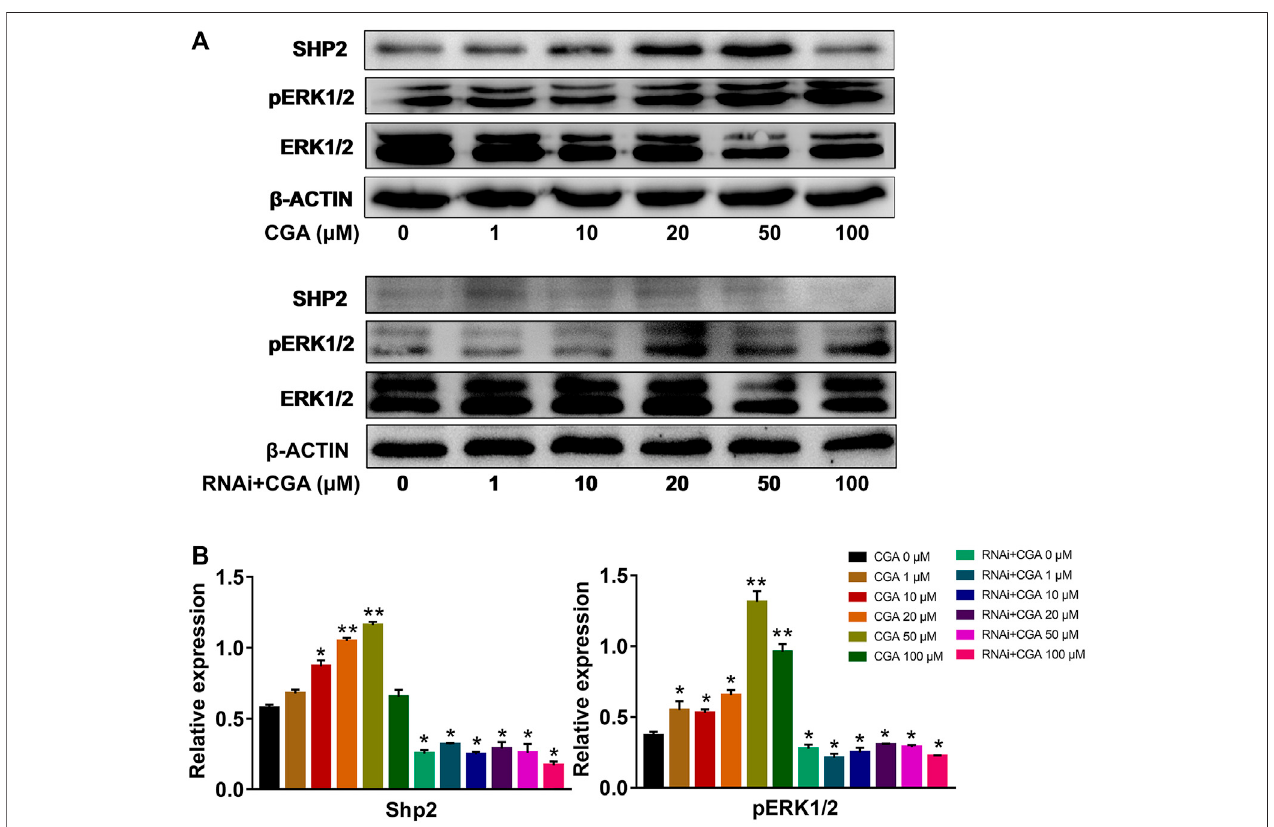
FIGURE 5 | CGA activated SHP2-MAPK signaling pathway. C18-4 cells and Shp2 knockdown C18-4 cell (RNAi) were cultured with CGA (1, 10, 20, 50 and 100 μ M)for36 h,andgeneexpressionwasdeterminedusingWesternblotting. (A) WesternblotanalysisoftheeffectofCGAontheSHP2-MAPKsignalingpathway. (B) The results of statistical analyses. Values are expressed as the mean ± SD ( n = 3) * p < 0.05, ** p < 0.01 vs CGA 0 μ M.